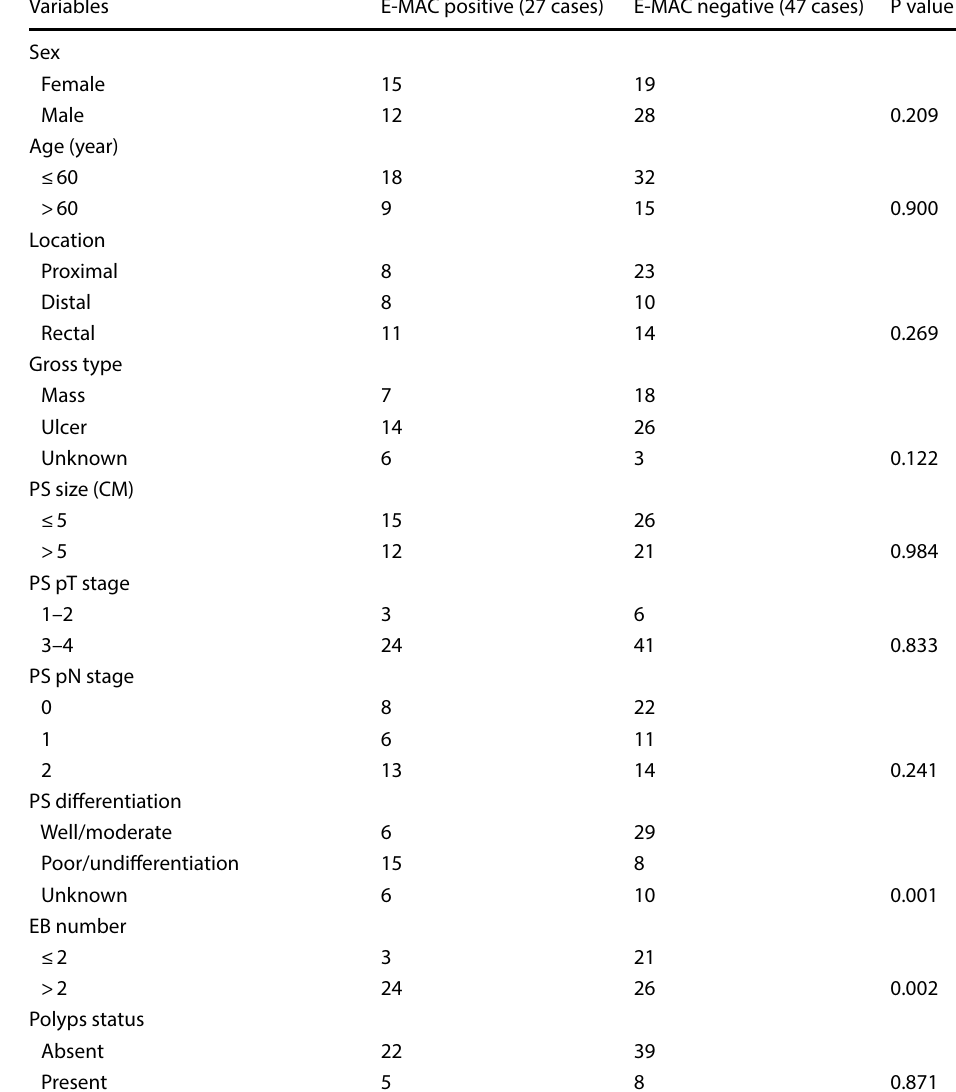
Table 3 The clinicopathological features of colorectal MAC patients according to the endoscopic biopsy